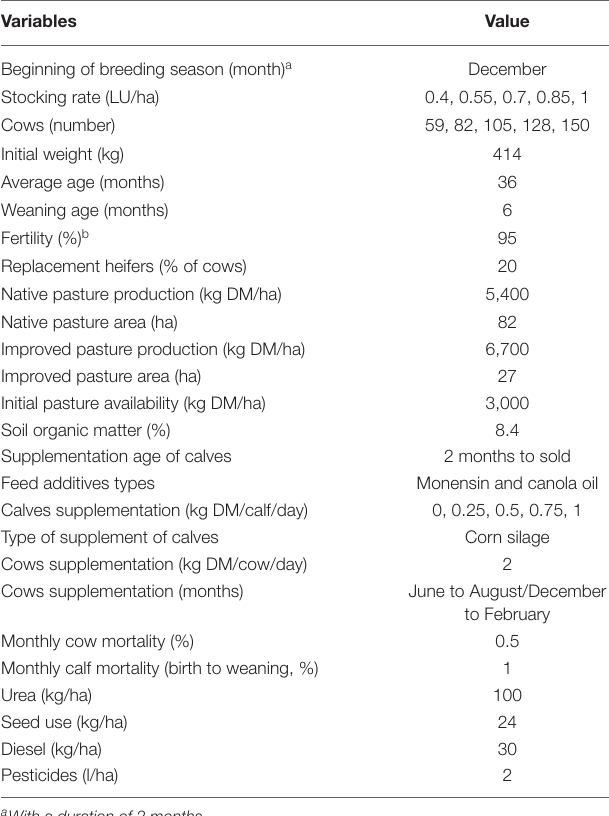
TABLE 1 | Input data.